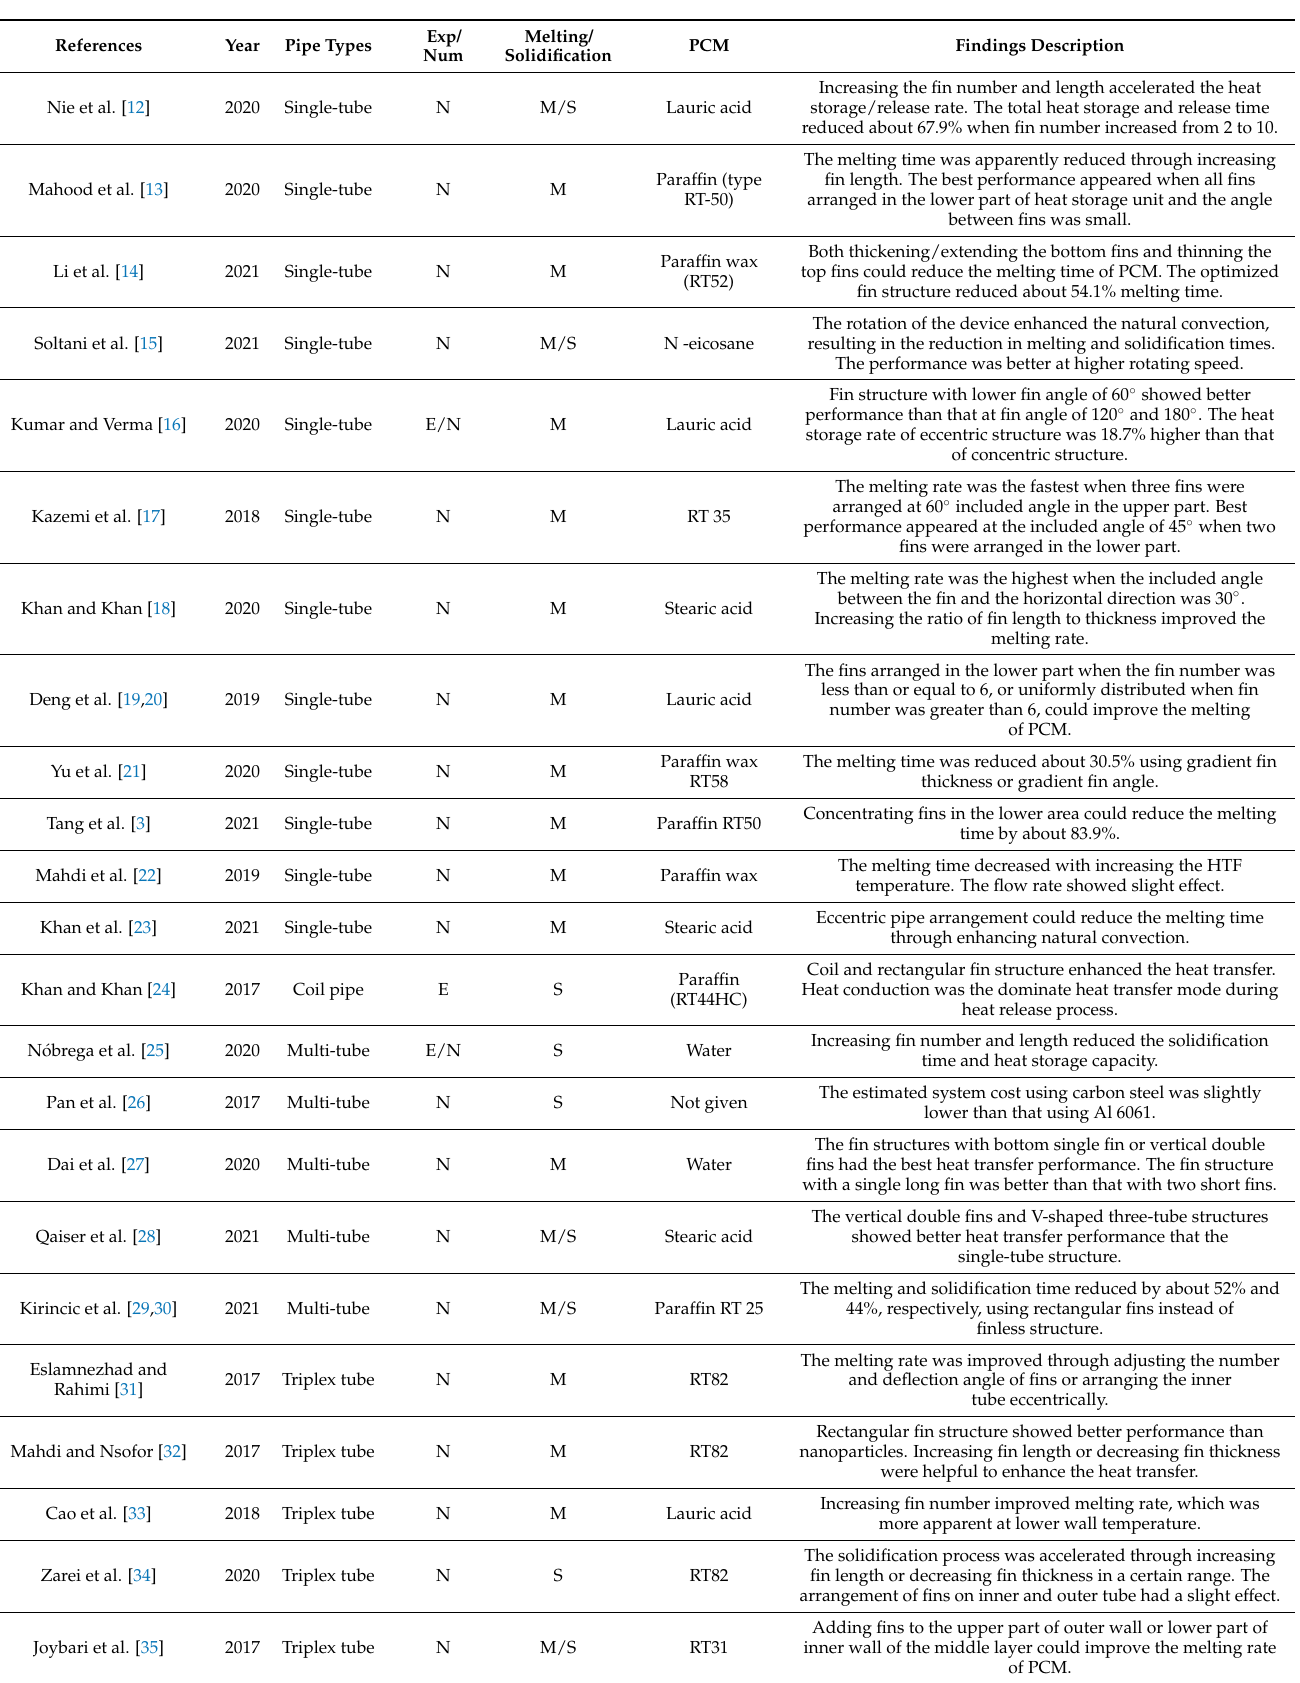
Table 1. Application of rectangular fins in LHTES